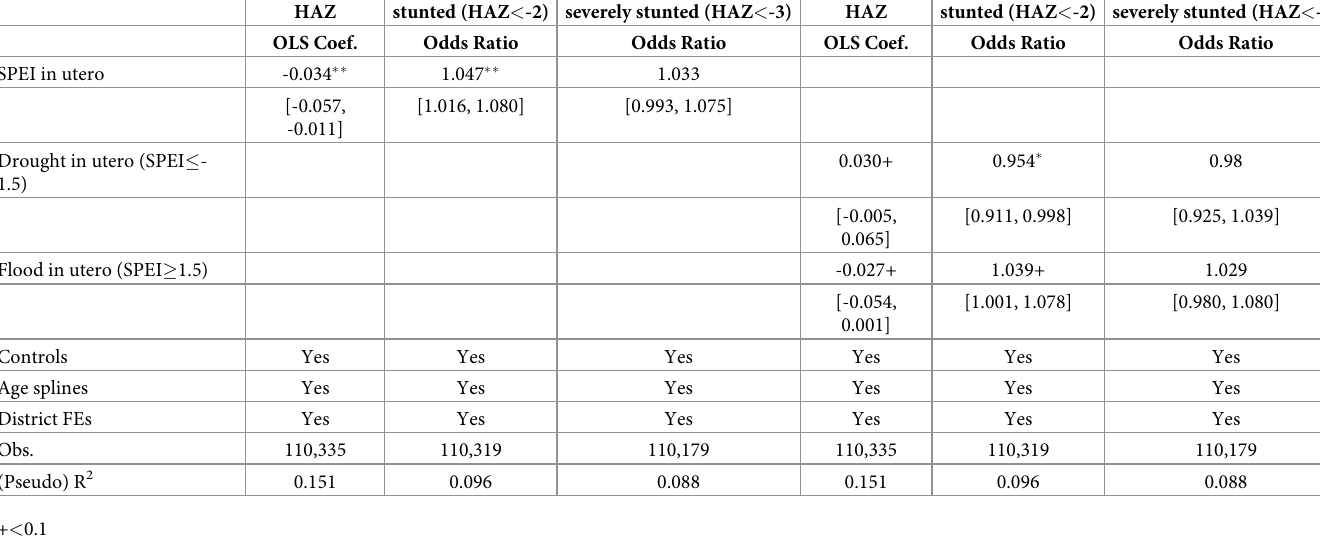
Table 3. Effects of monsoon season climate during in-utero on undernutrition, children aged